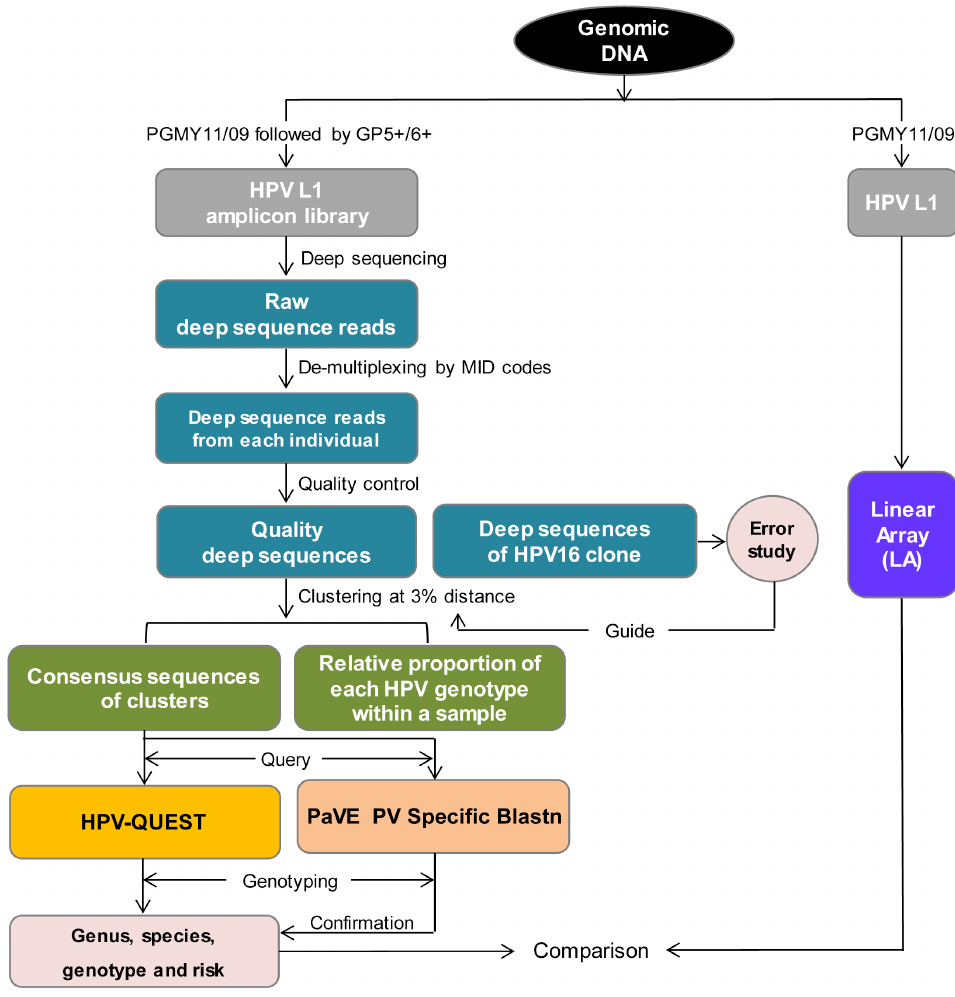
Figure 2. Bioinformatic pipeline of sequence analysis. HPV L1 was amplified by PCR using PGMY or nested PCR using PGMY/GP+ from genomic DNA from each individual and subjected to Linear Array (LA) and deep sequencing/HPV-QUEST, respectively, to compare sensitivity and coverage in HPV genotype capturing. Raw deep sequencing reads generated from pooled HPV L1 libraries were separated and assigned to each individual according to MID sequence codes. Quality control removed low quality reads. Quality sequences of an HPV16 clone were aligned to HPV16 reference sequence (GI |333031) to study errors due to PCR and deep sequencing. To study HPV L1 sequences at variant level, quality sequences were clustered at 3% pairwise distance [51]. Consensus sequence derived from each cluster represented an HPV variant, and relative proportion of each HPV genotype within a sample served as a reference rather than a quantification of viral population structure. Consensus sequences were queried in HPV-QUEST to obtain HPV genus, species, genotype and oncogenicity. Papillomavirus Episteme (PaVE) Specific Blastn was used to confirm HPV-QUEST genotyping results, and Nationa Center for Biotechnology Information (NCBI) Blastn was applied to evaluate discrepancies of genotyping by HPV-QUEST and PaVE. NGS/HPV-QUEST was compared with LA with respect of sensitivity and coverage in identifying HPV genotypes and variants.